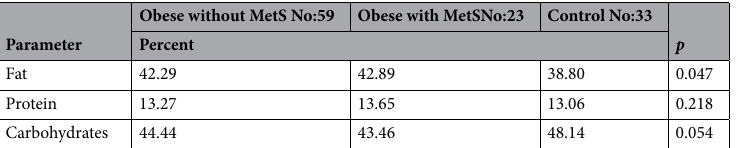
Table 5. The percent of Calories delivered from fat, protein, and carbohydrates of total daily calories intakeof the studied women. Significance difference p ≤ 0.05.